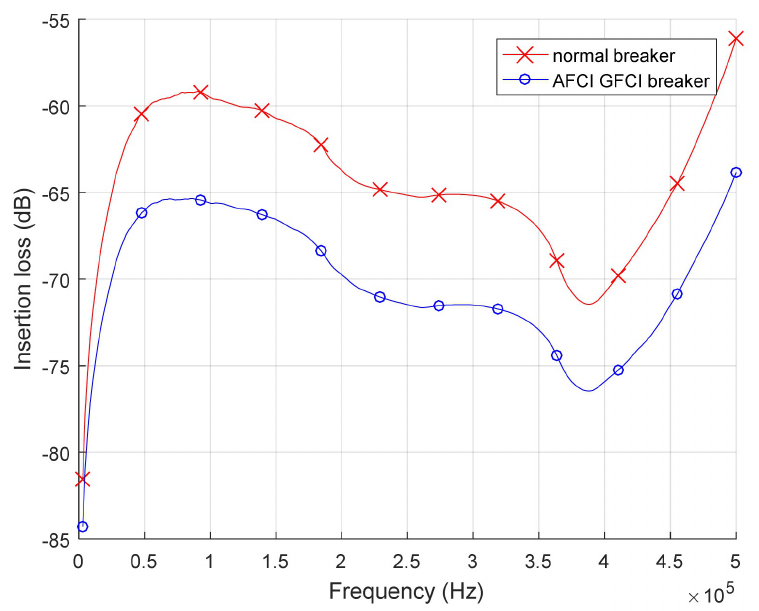
Figure 11. The average IL with normal breakers and AFCI and GFCI